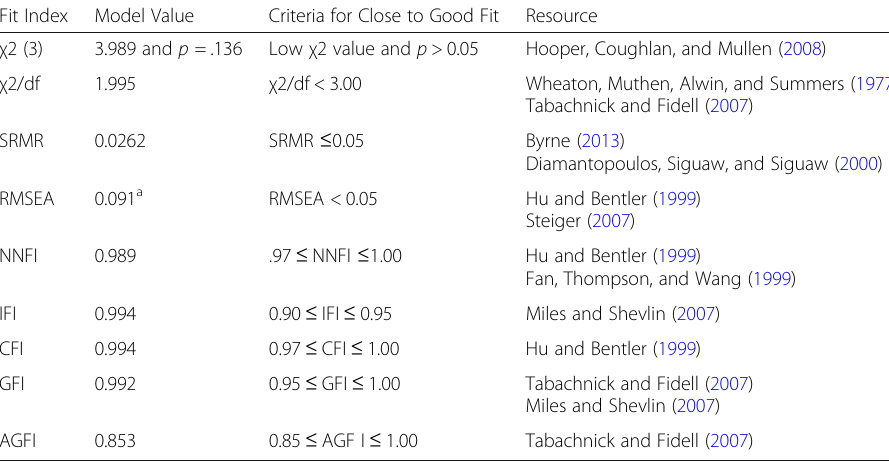
Table 5 Model fit indices